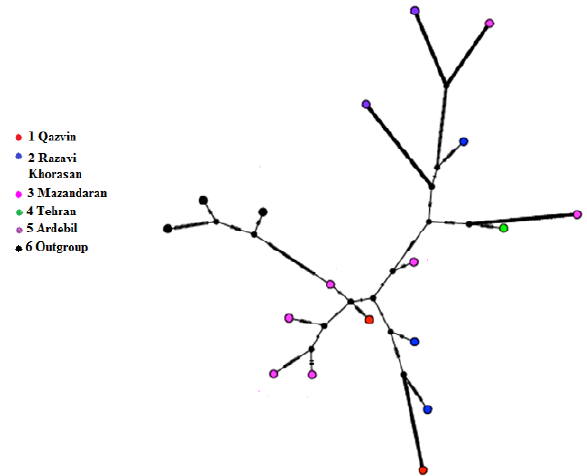
clinopodioides provinces.